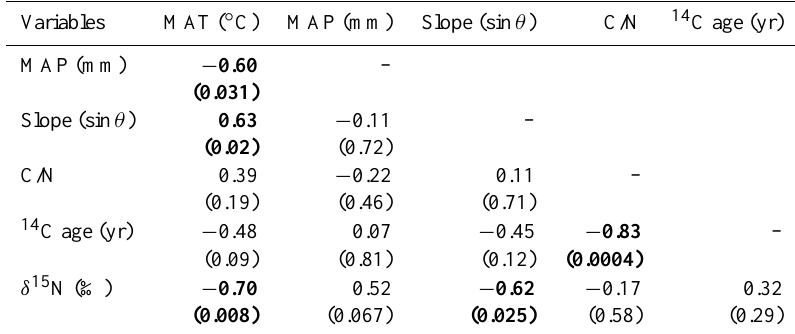
Table 1. Correlation matrix (Pearson) for soil samples ( n = 13) from the Central Range, Taiwan. Values in bold are different from 0 with a significance level of α = 0.05; P values are given in parentheses.